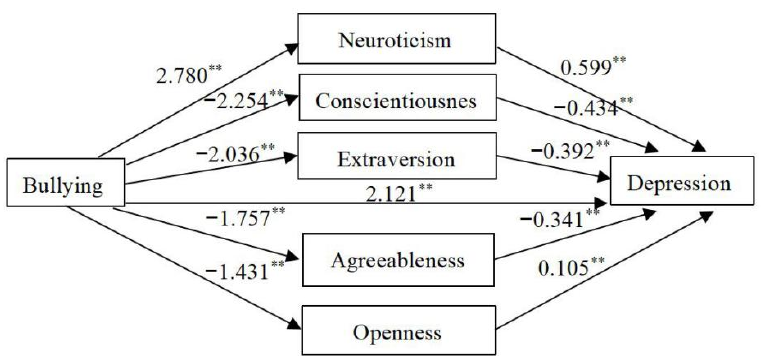
Figure 1. The pathway of predicting depression by school bullying.